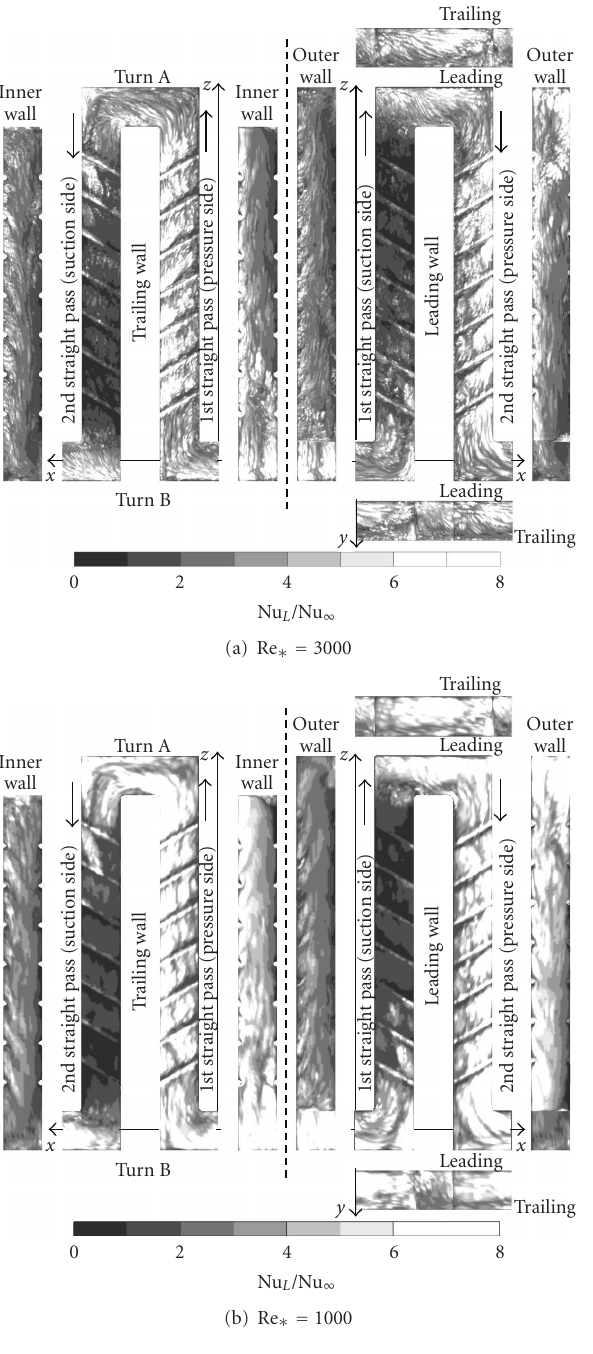
Figure 4: Instantaneous profiles of Nusselt number (60 ◦ rib NP, Re ∗ = (a) 3000 and (b) 1000, Ro ∗ = 1, and Ra ∗ = 0).